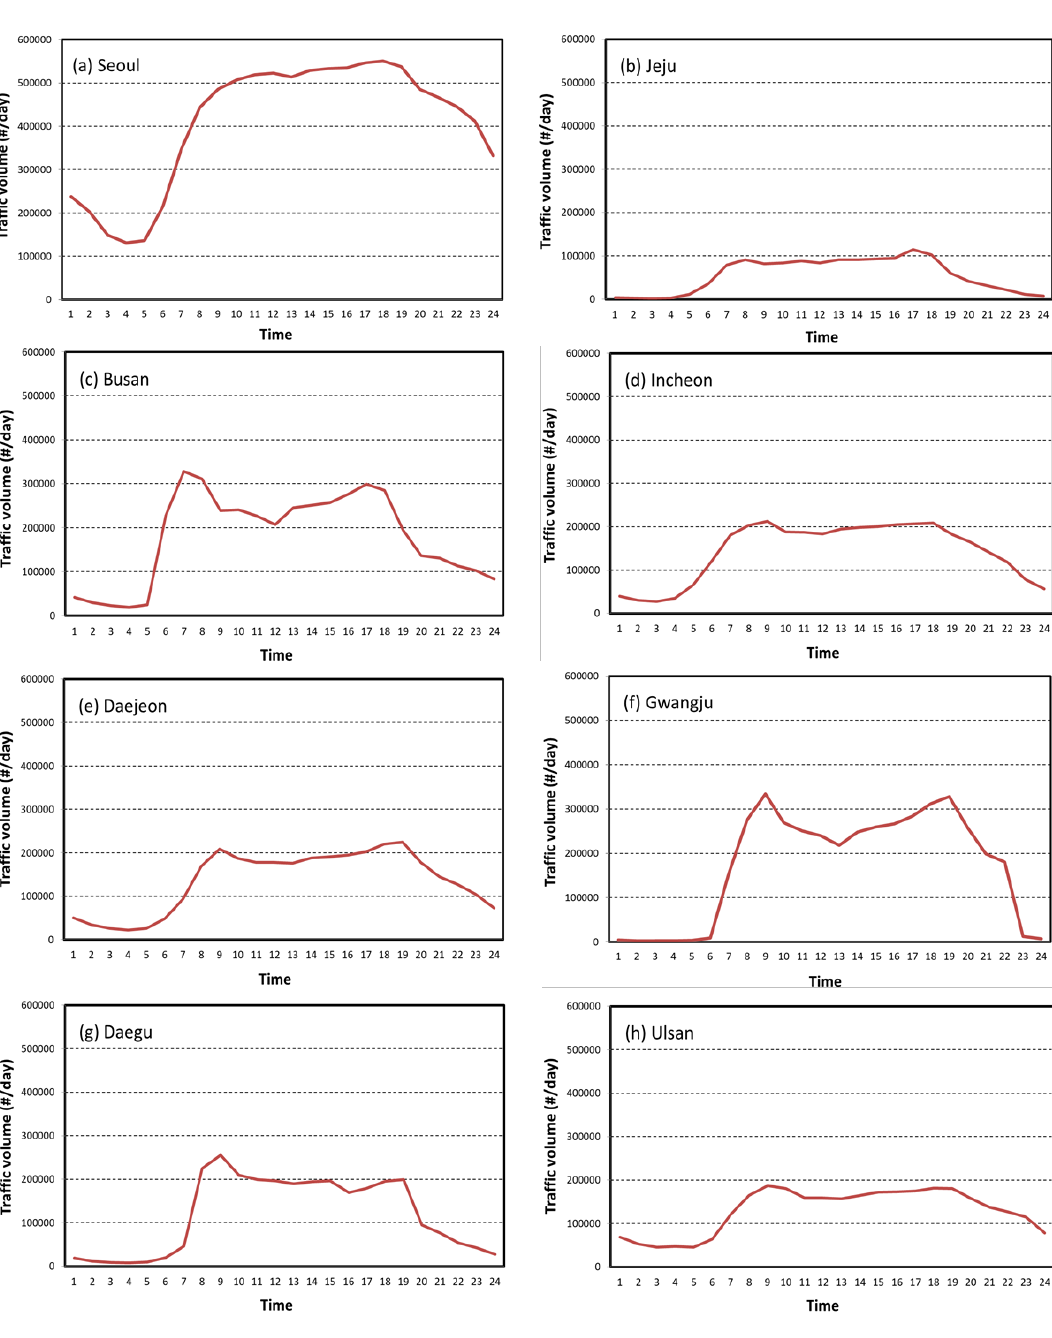
Figure 6. Diurnal variation of traffic volume in each region during 2016 and 2018.